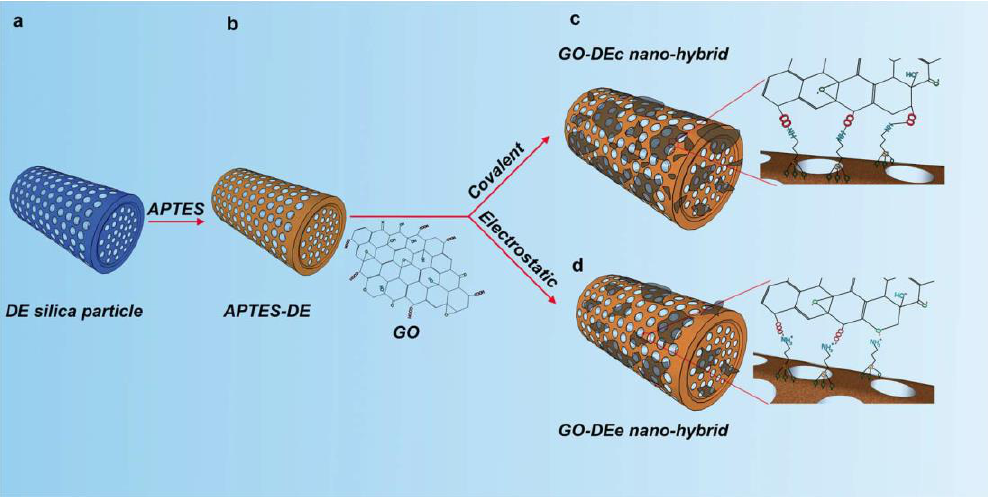
Figure 6. Schematic representation of GO nanosheet functionalization of the diatom frustule surface via electrostatic or covalent chemical approach for the realization of nano-hybrid drug delivery devices. Reproduced with permission from [74], Royal Society of Chemistry, 2013.